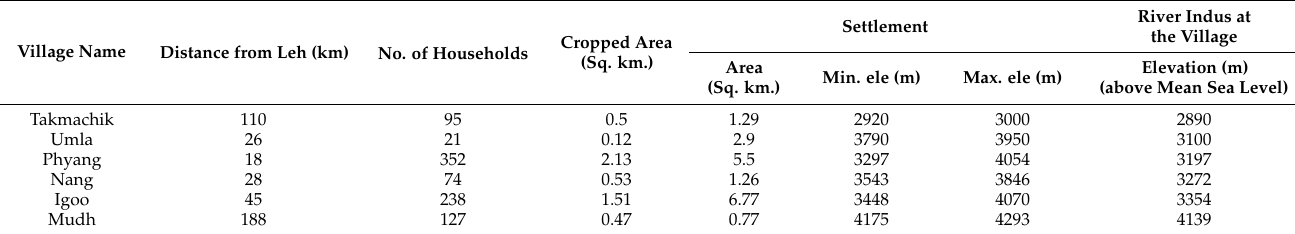
Table 1. Basic information of study